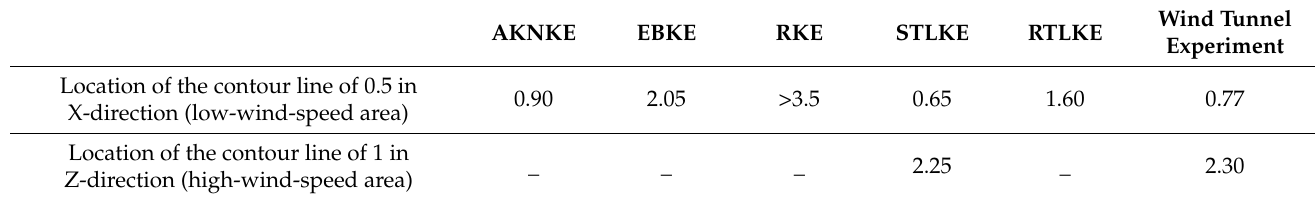
Table 12. Location of contour line at Y = 0 (turbulent kinetic